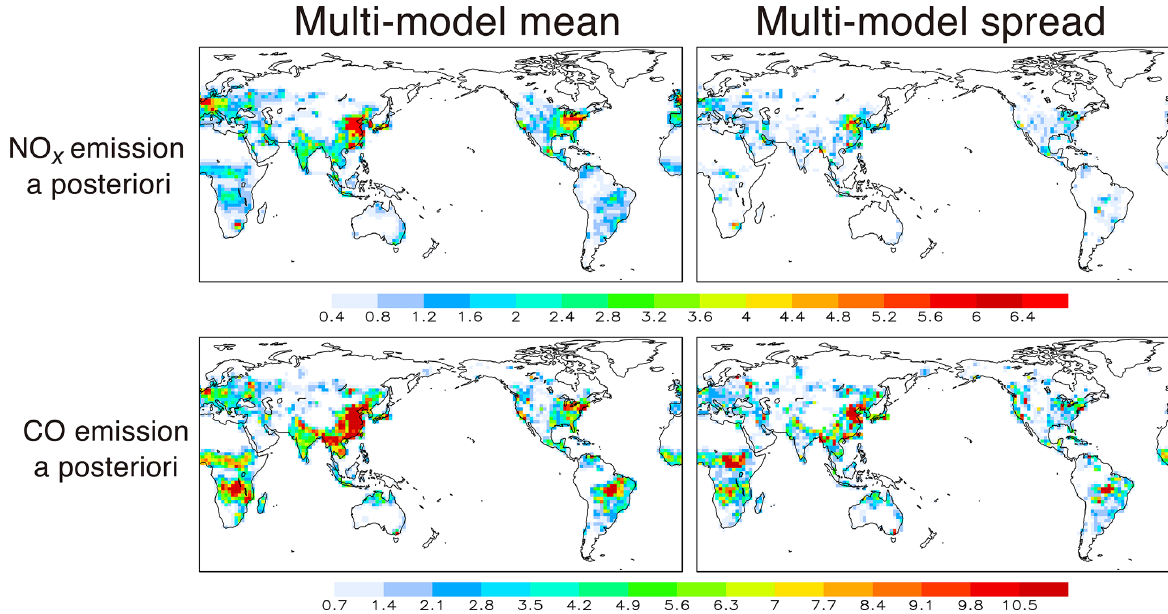
Figure 17. Same as Fig. 16, but for the multi-model mean and